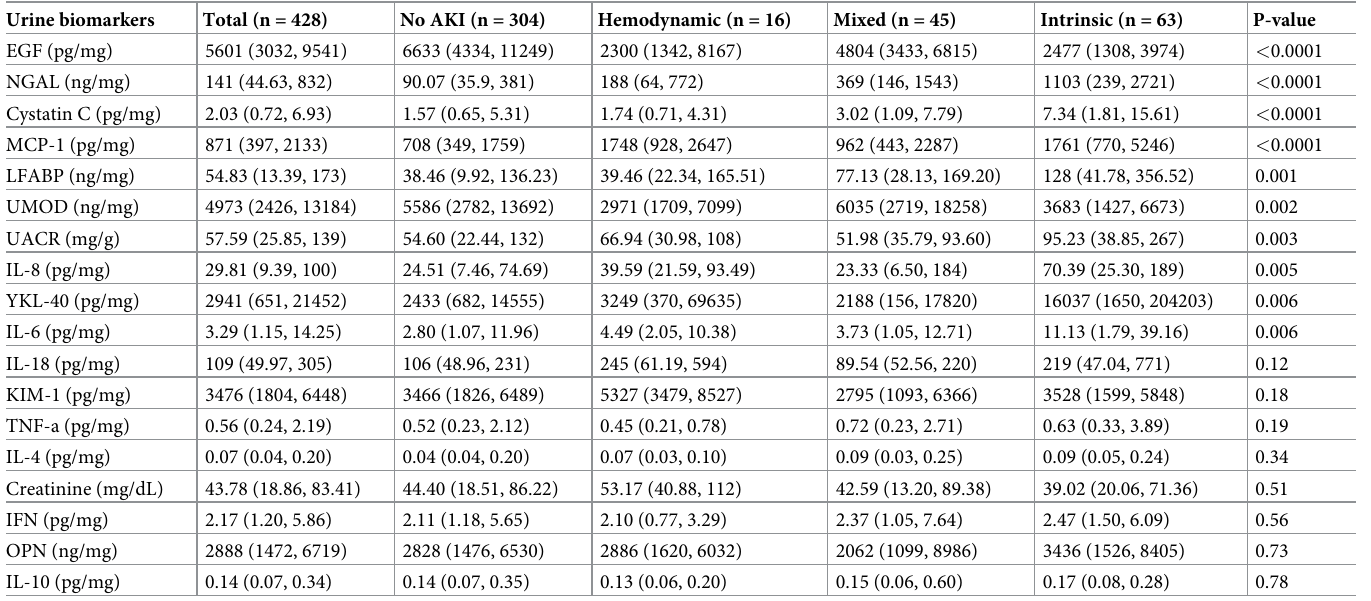
Table 4. Distribution of biomarkers among AKI phenotypes at time of organ procurement.